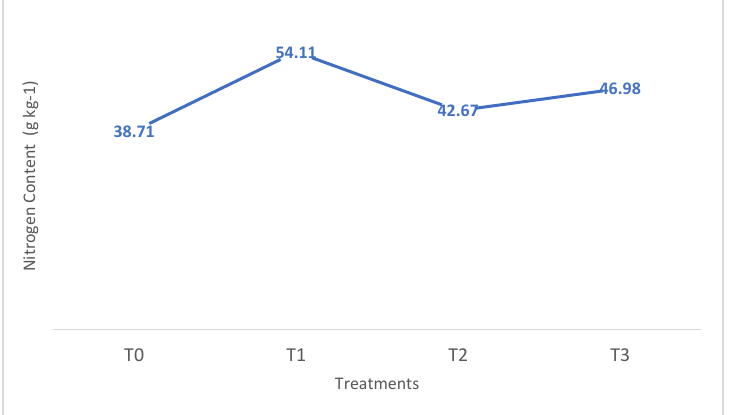
Figure 7. Lucerne nitrogen uptake under inoculation with liquid formulation (T0, T1, T2, and T3) of Sinorhizobium meliloti .